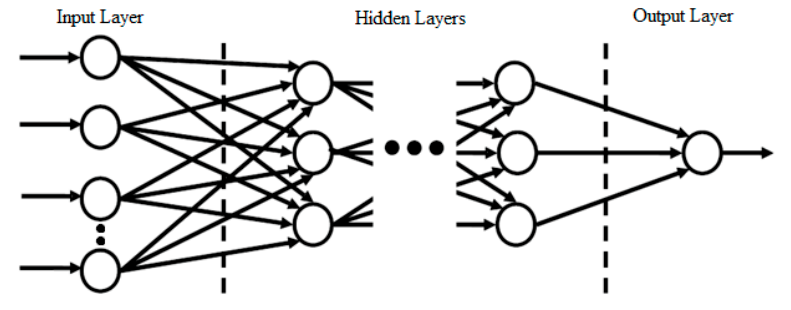
Figure 1. Multilayer Perceptron (MLP) network architecture.